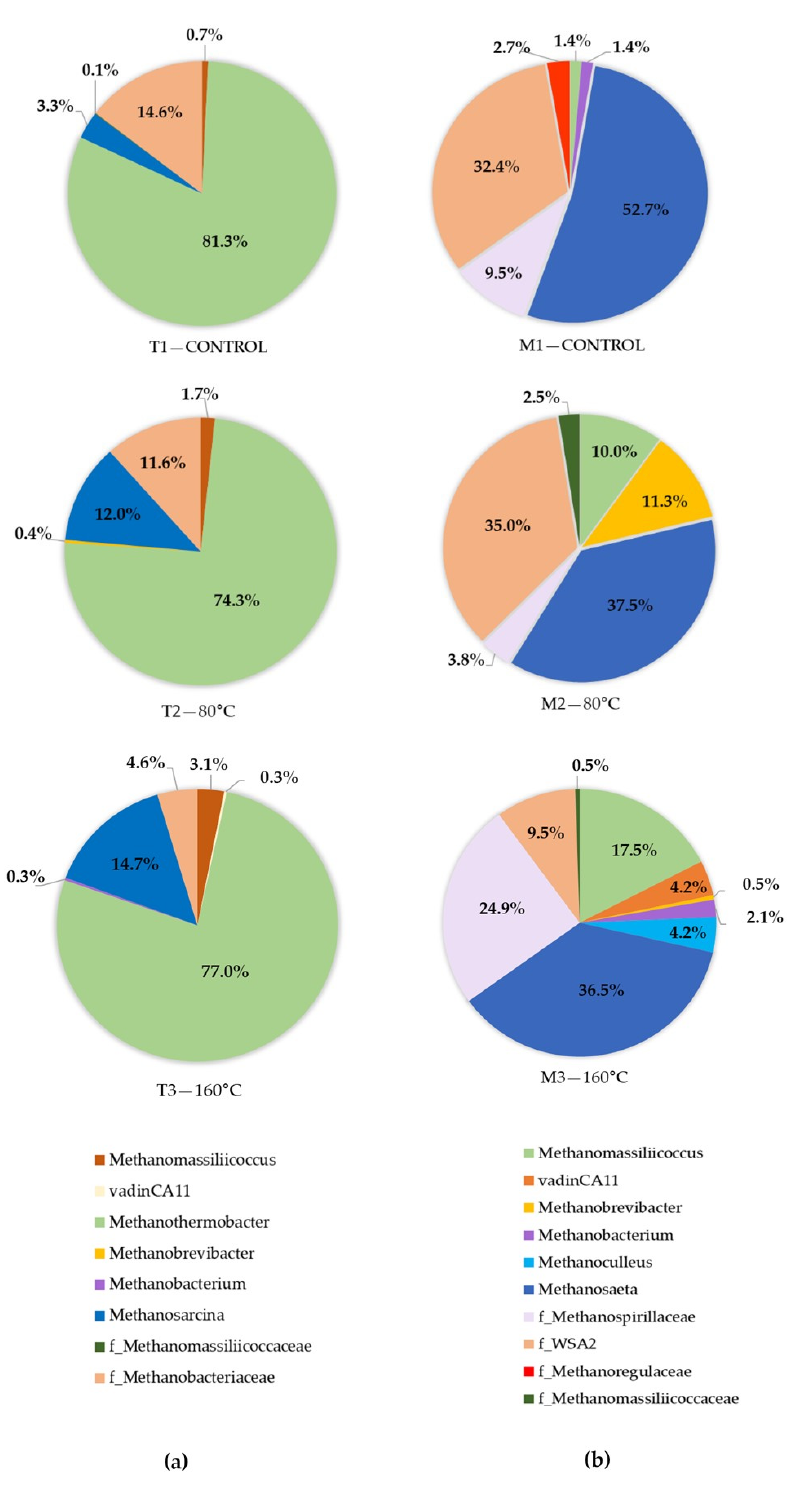
Figure 5. Taxonomic distribution of methanogens found in the mesophilic and thermophilic digesters at the genus level [Undefined genera in database were shown as family (f_) level as the lowest taxonomic level designated.].